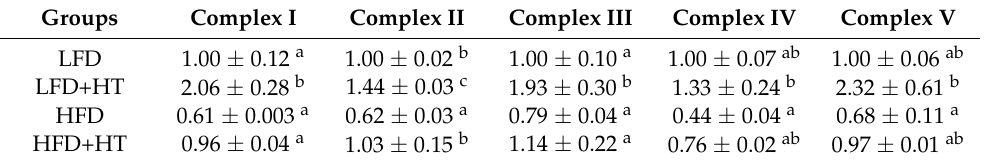
Table 4. Activities of mitochondrial complexes in the liver of blunt snout bream fed with experimental diets.